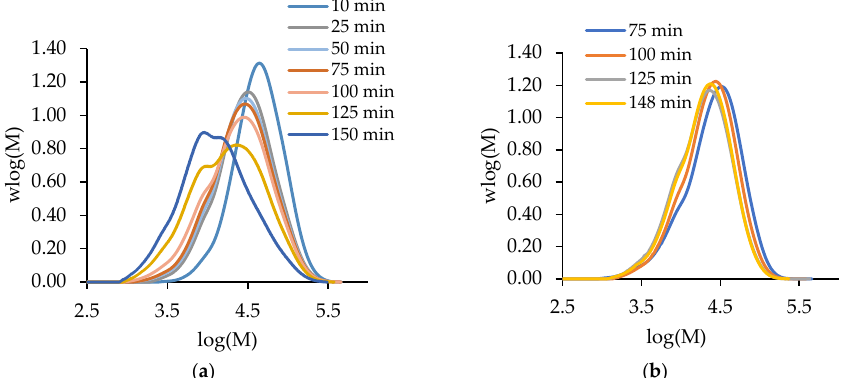
Figure 1. The evolution of polymer MMDs over time for ( a ) semi-batch and ( b ) batch MA homopolymerization with a final monomer/polymer content of 20 wt% synthesized in 75/25 EtOH/H 2 O at 60 °C with 1 wt% AIBN.